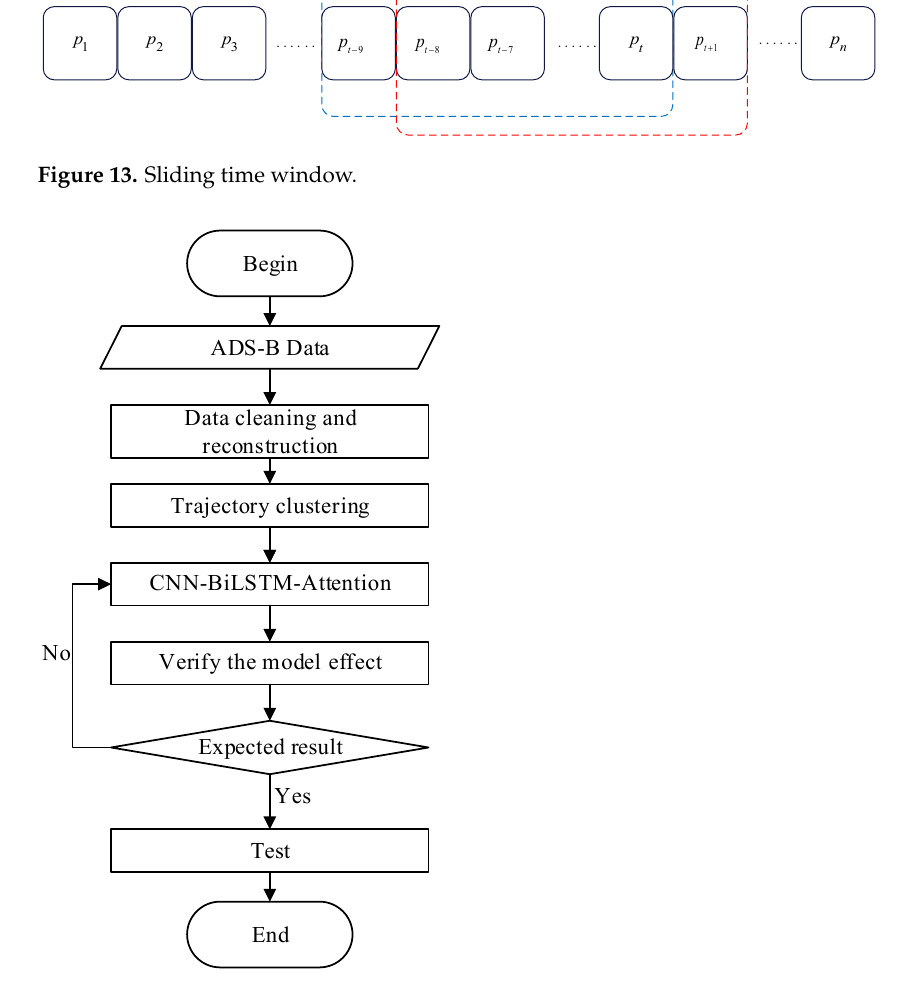
Figure 14. Experimental flowchart.